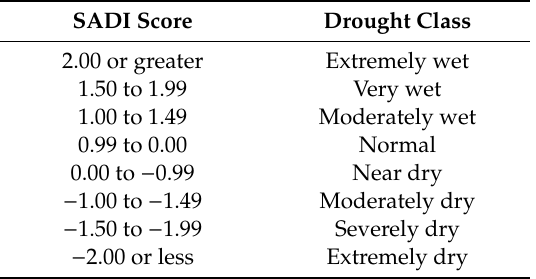
Table 1. Classification of drought according to the Standardized Agricultural Drought Index